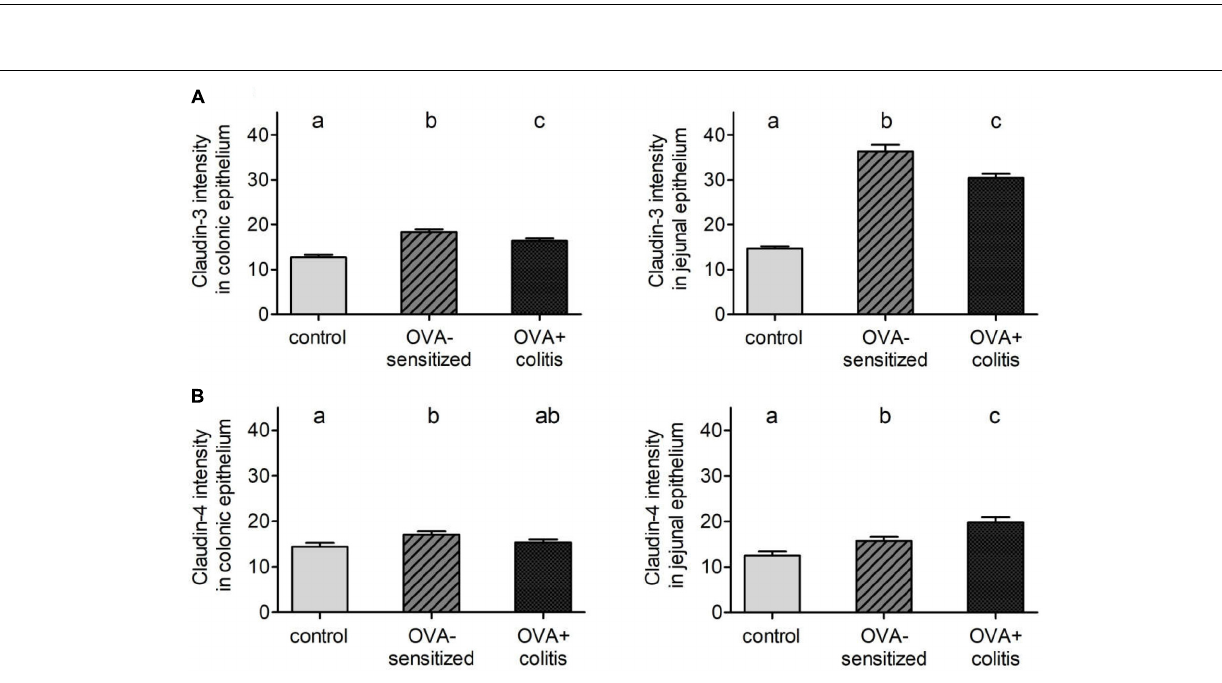
Frontiers in Physiology |